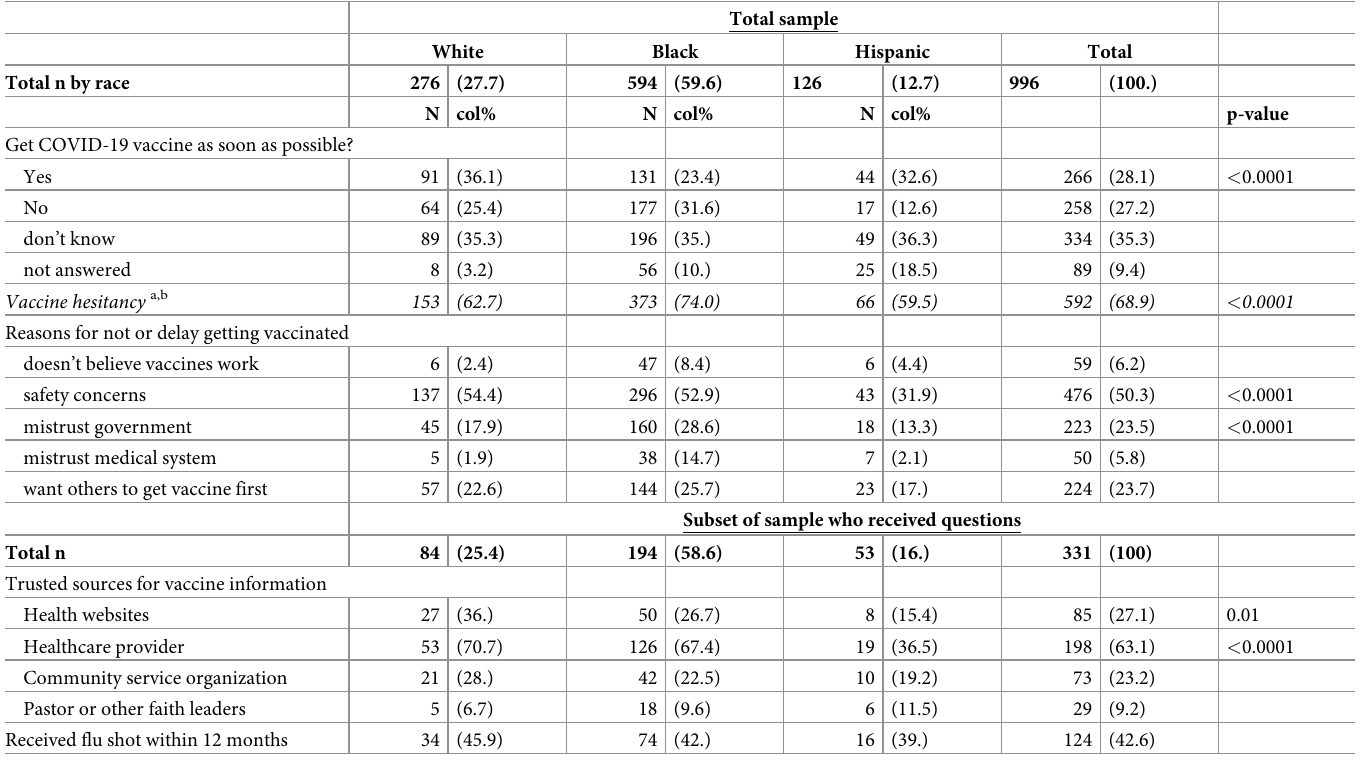
Table 2. Prevalence and features of vaccine hesitancy stratified by race, ACCORD study, North Carolina August–November 2020. Total sample White Black Hispanic